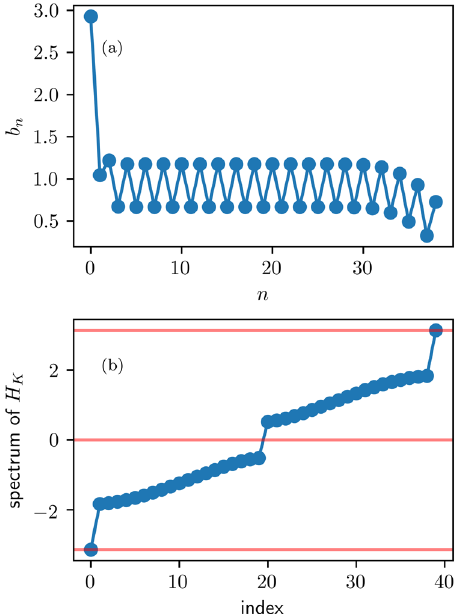
Fig. 4 Parameters of the Krylov chain for the free case. The hopping parameters b n for the Krylov chain (panel a ) and the corresponding spectrum (panel b ) for the free case J z = 0, where J z is the interaction strength. The strength of the magnetic fi eld is g = 0.3, the period T = 8.25, and the system size L = 20. n labels the sites of the Krylov chain. The horizontal red lines in panel b indicate energies at 0, ± π . Panel b shows modes at ± π that are clearly separated from bulk states by an energy